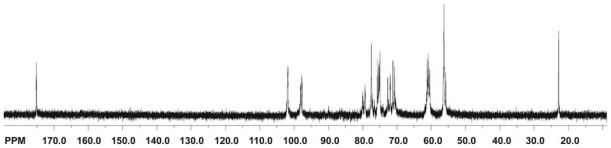
Liquid-state 13C NMR spectrum of chitosan; DA = 48. Spectrum was recorded at 100 MHz and 70 °C in D2O (pD ~ 5) relative to internal acetone (δC 31.45).